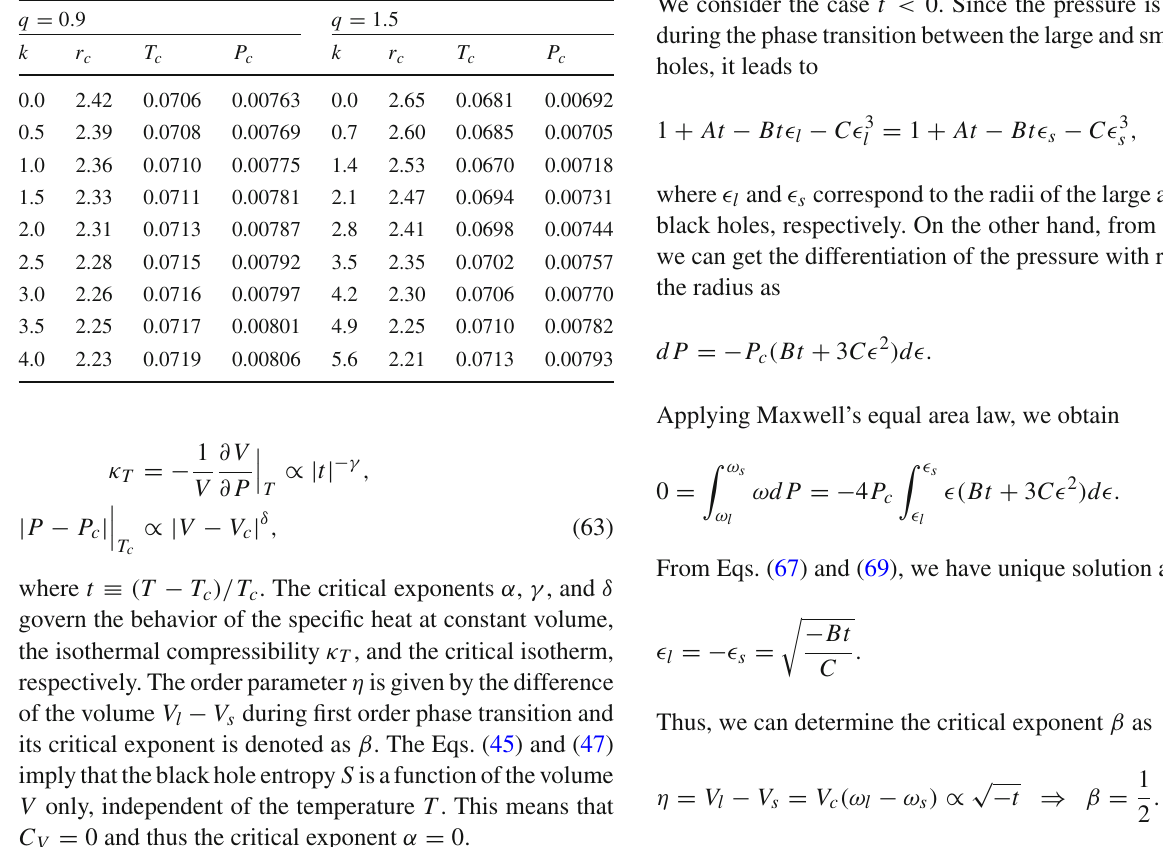
Table 3 The numerical results for the critical radius, temperature and pressure are given in terms of the nonlinear coupling under various values of the electric charge, at α = 0 .